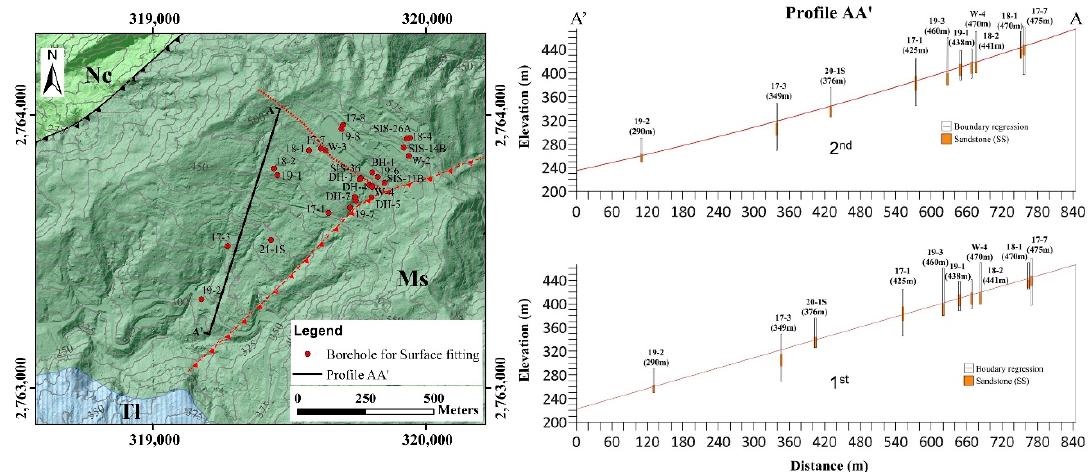
Figure 7. Cross-section A-A’ showing the resulting surface interpolation polynomials of the first (red straight line) and second (red curved line) order, for the top of the thick sandstone (L4) based on the borehole data. Each polynomial function has a different arrangement of boreholes on the profile. The deviation from the top sandstone with the second-order model is smaller than that with the first-order model.